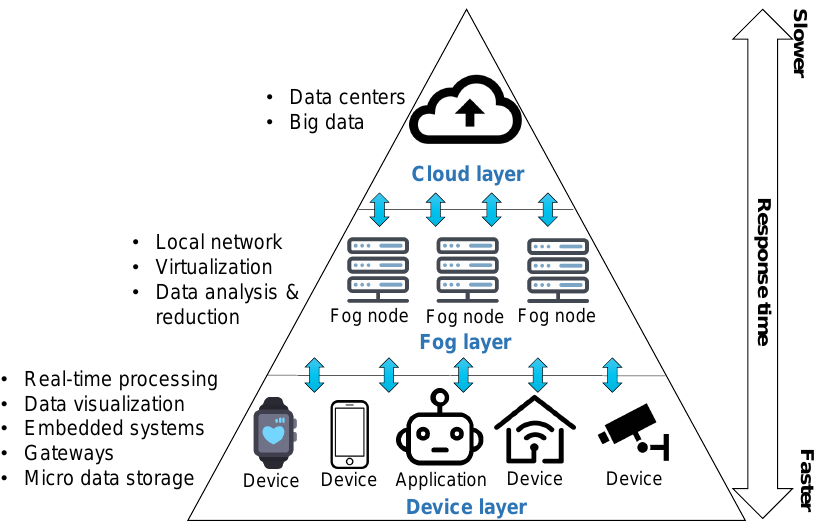
Figure 8. Illustration of fog computing architecture including device layer, fog layer, and cloud layer and their main